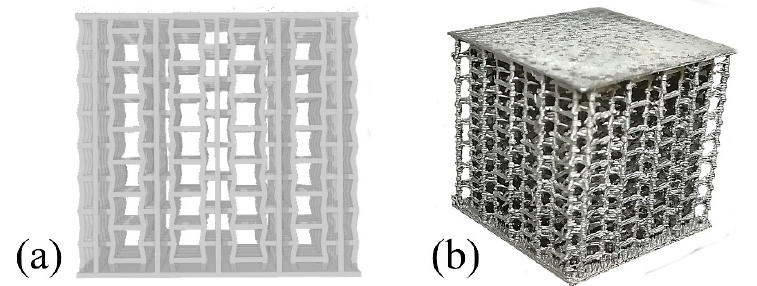
Figure 1. Aluminum cellular lattice: ( a ) CAD model and ( b ) cast sample.